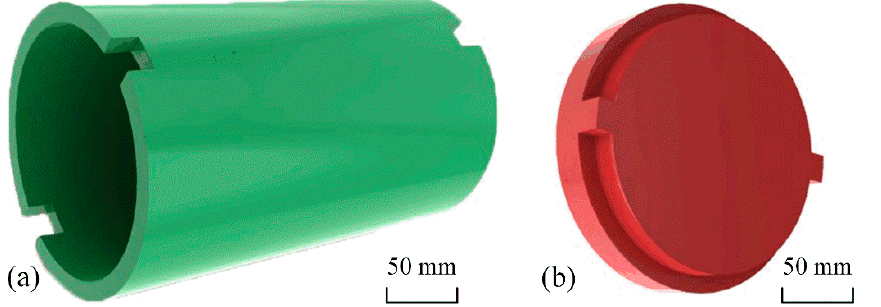
Figure 1. Grinding roller and holder. ( a ) model of the grinding roller; ( b ) fixture of the grinding roller. During the test, the striped morphology of the shell surface was used as the design model, and the striped non-smooth structure was selected as the design morphology of the grinding roller surface. The depth and number of stripes were selected as the factors of the stripe texture, and the stripe pattern was uniformly distributed around the circumference of the grinding roller surface. The level values of the designed factors are shown in Table 1. Table 1. Factors and levels table of the bionic grinding roller. Levels